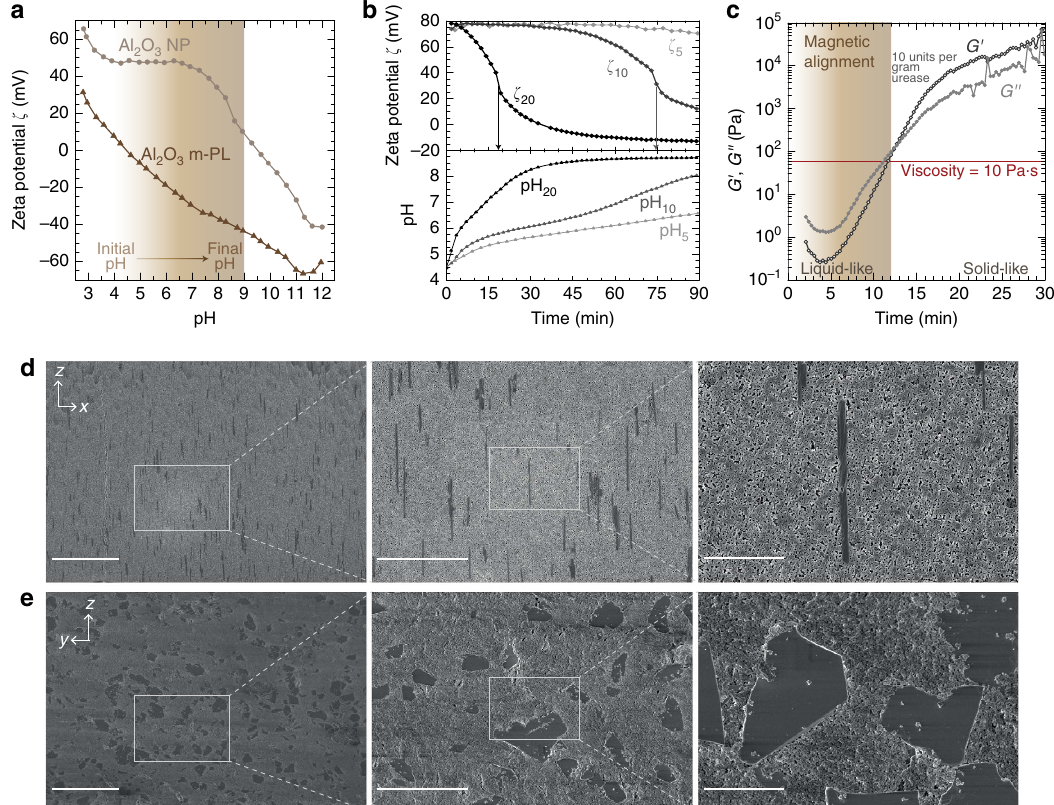
Figure 2 | Consolidation kinetics and microstructured ceramics. ( a ) Determination of the zeta potential of the Al 2 O 3 NP and the Al 2 O 3 m-PL used in this study. ( b ) Evolution of the zeta potential ( z x ) and pH (pH x ) during coagulation of the slurry depending on the urease concentration in enzymatic units, where x refers to the enzyme concentration in units of urease for 1g of alumina. ( c ) Storage ( G’ ) and loss ( G’’ ) moduli as a function of time for a suspension containing 50 vol% of particles at a Al 2 O 3 NP:Al 2 O 3 m-PLvolume ratio of 90:10, 0.5wt% of urea with respect to alumina and 10 units per g of total alumina of urease. ( d , e ) Scanning electron micrographs at different magnifications of polished cross-sections of green bodies cut along ( d ) the ( x – z ) plane and ( e ) the ( z – y ) plane (scale bars from left to right, 50, 20 and 5 m